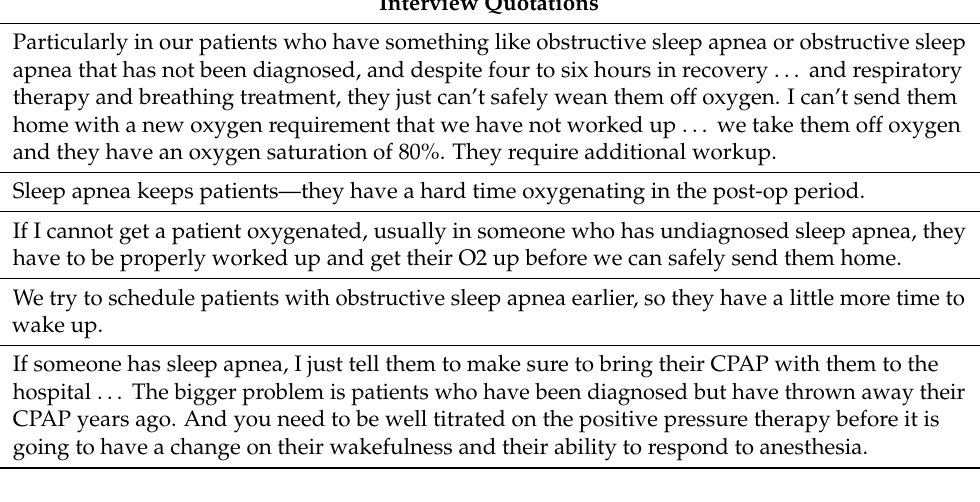
Table 2. Obstructive Sleep Apnea and Unplanned Admission Interview Quotations